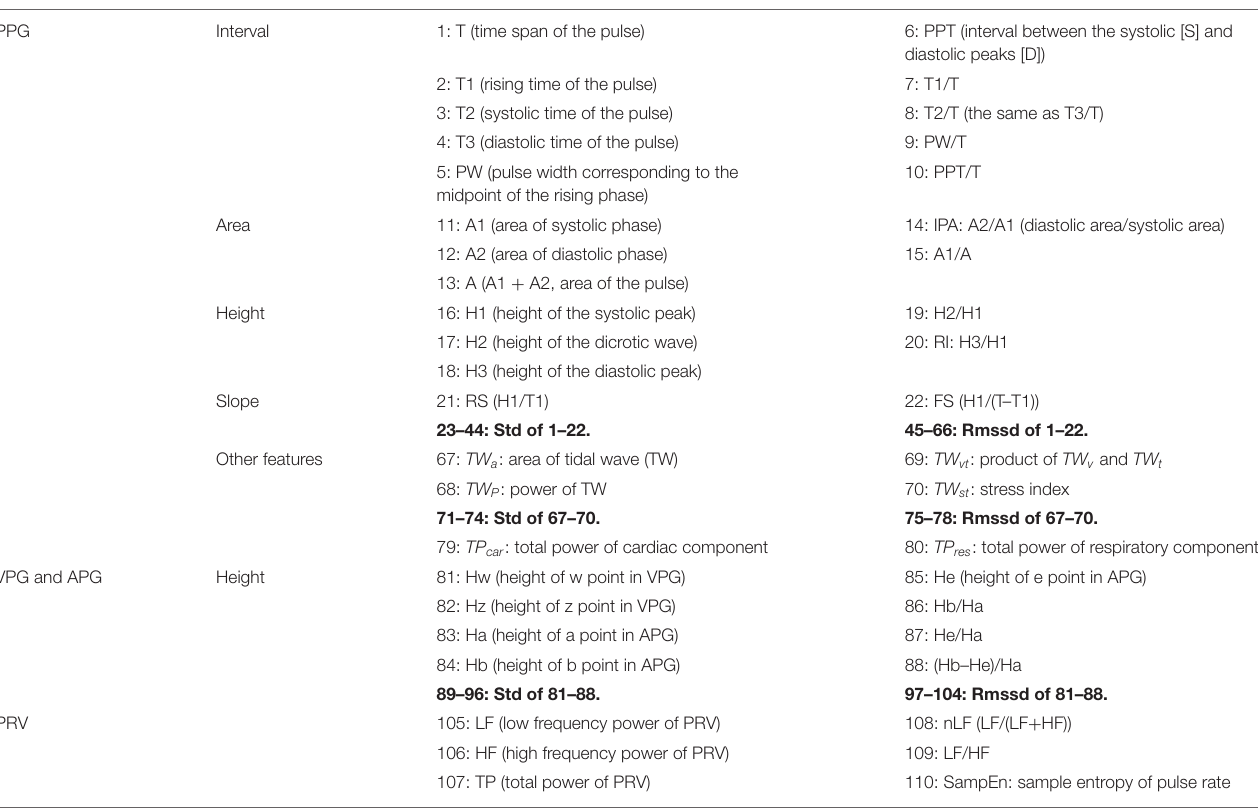
TABLE 1 | The 110 features extracted from PPG, VPG (first derivative or velocity of PPG), APG (second derivative or acceleration of PPG), and PRV (pulse rate